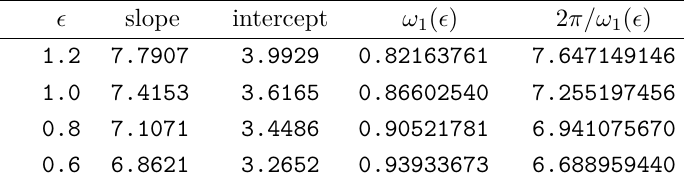
Table 1 . Linear fits for the lines on figure 12, with the slopes compared with the predictions of the resonance condition (4.11). The values of ω 1 ( (cid:15) ) follow from the (numerical except for (cid:15) = 1 ) solution of the eigenvalue problem (2.10), as described in section 2.2.